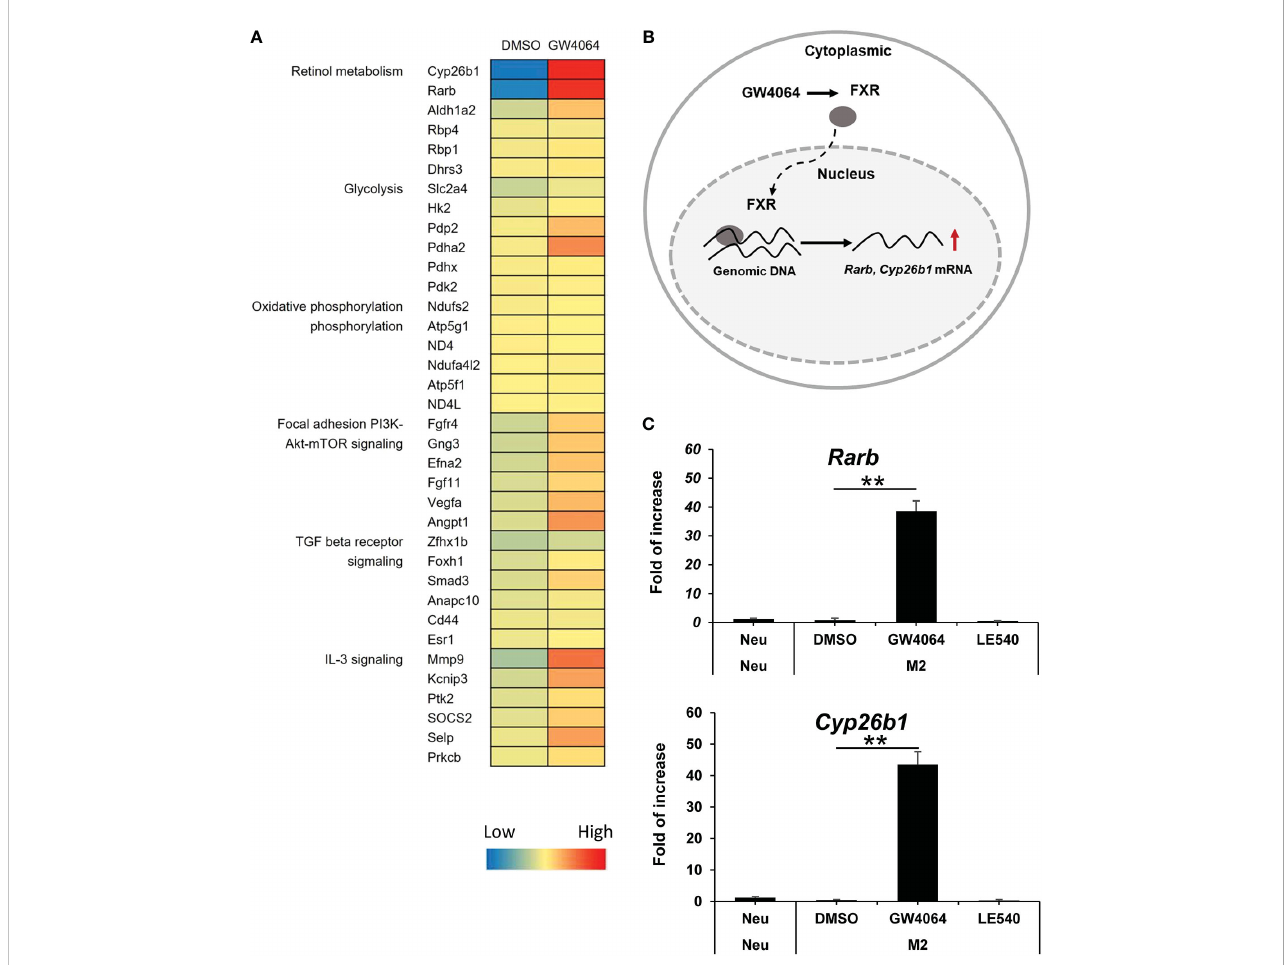
FIGURE 3 Rarb and Cyb26b1 expression was increased by FXR activation with GW4064 in M2 macrophages. (A) BMDMs were treated with DMSO or 10 µM of GW4064 under M2-inducing conditions for 1 d. The mRNAs were isolated and checked for integrity and a DNA micro array then used to pro fi le differential gene expression. The heatmap analysis shows pro fi ling of gene alterations according to biological process annotations and pathway analysis. (B) A diagram showing that RARB and CYP26B1 are included in the retinoic acid signaling pathway. (C) Real-time PCR was performed to assess Rarb and Cyb26b1 mRNA gene expression in BMDMs treated with DMSO, 10 µM of GW4064, or 2 µM of LE540 under M2-inducing conditions for 1 d and left untreated as a Neu condition. Each experiment was performed in triplicate and repeated three times. The results of the representative data are shown as mean +/- SD. Analysis of variance (ANOVA) was used for the statistical analysis. ** P < 0.01. Rarb : Retinoic acid receptor beta; Cyp26b1 : Cytochrome P450 family 26 subfamily B member